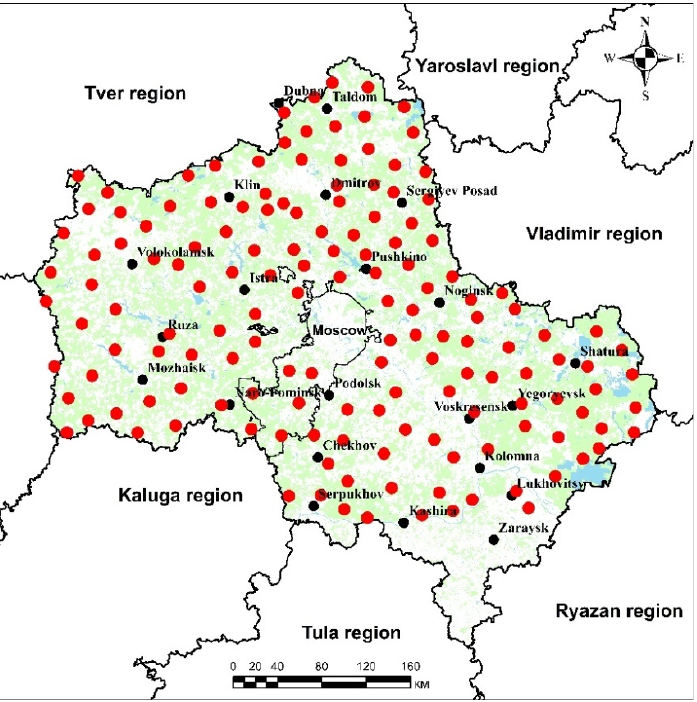
Figure 1. Location of the sampling sites in the Moscow region.